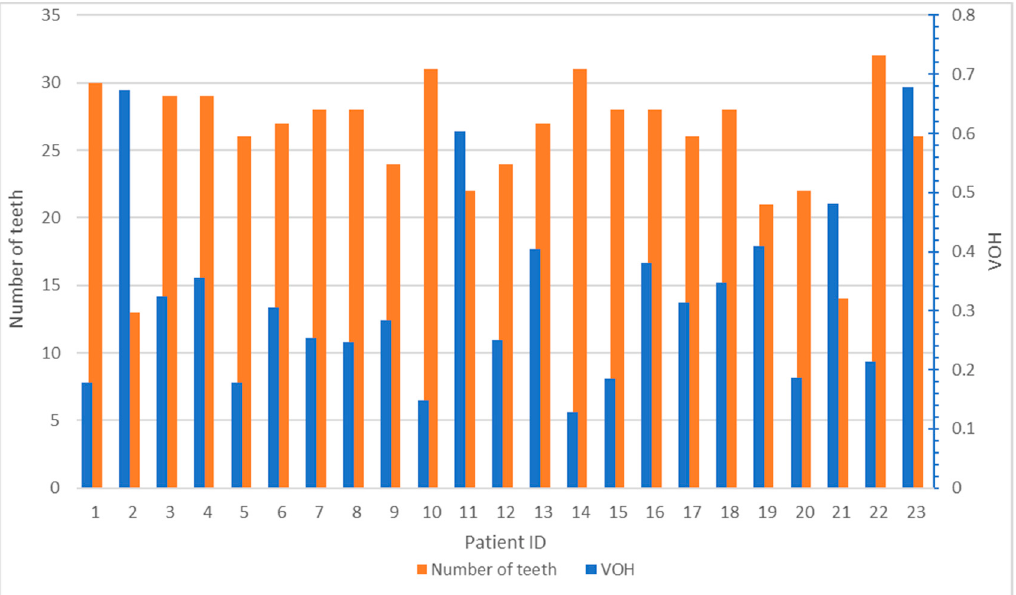
Figure 9. Comparison between VOH (in blue) and the number of prosthetic/natural teeth present in the arches (in orange). As can be seen from the graph, patients with fewer teeth tend to have a higher VOH score.